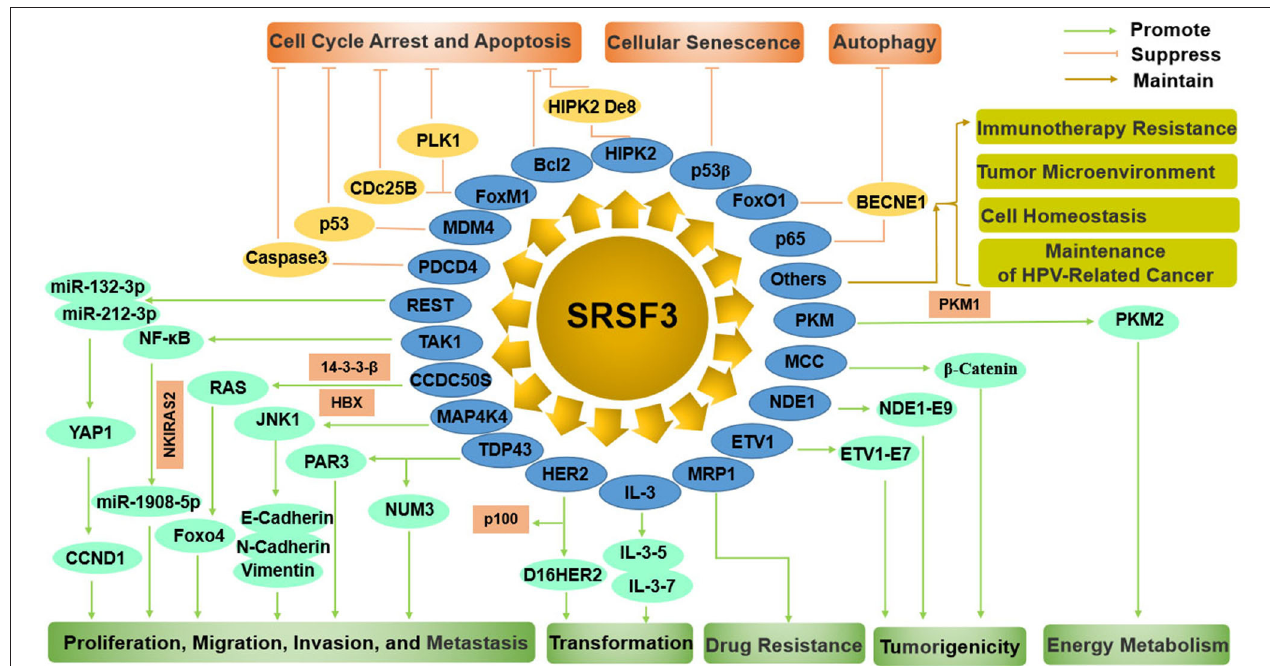
FIGURE 4 | The comprehensive mechanism of SRSF3 functions as an oncogene by regulating multiple splicing targets in cancer cells. On the one hand, SRSF3 can enhance cell proliferation, migration, invasion, metastasis, transformation, drug resistance, tumorigenesis, and energy metabolism. On the other hand, SRSF3 can inhibit cell cycle arrest, apoptosis, cellular senescence, and autophagy. SRSF3 is also involved in immunotherapy resistance, tumor microenvironment, cell homeostasis, and maintenance of HPV-related